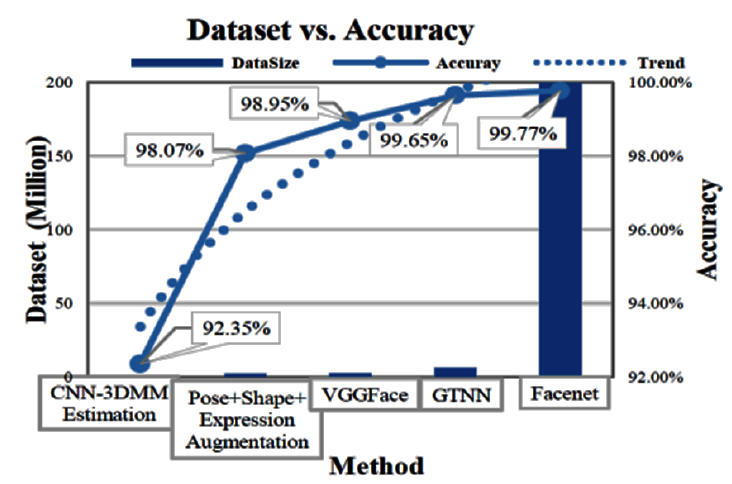
Figure 2. An illustration of accuracy with increasing dataset size.